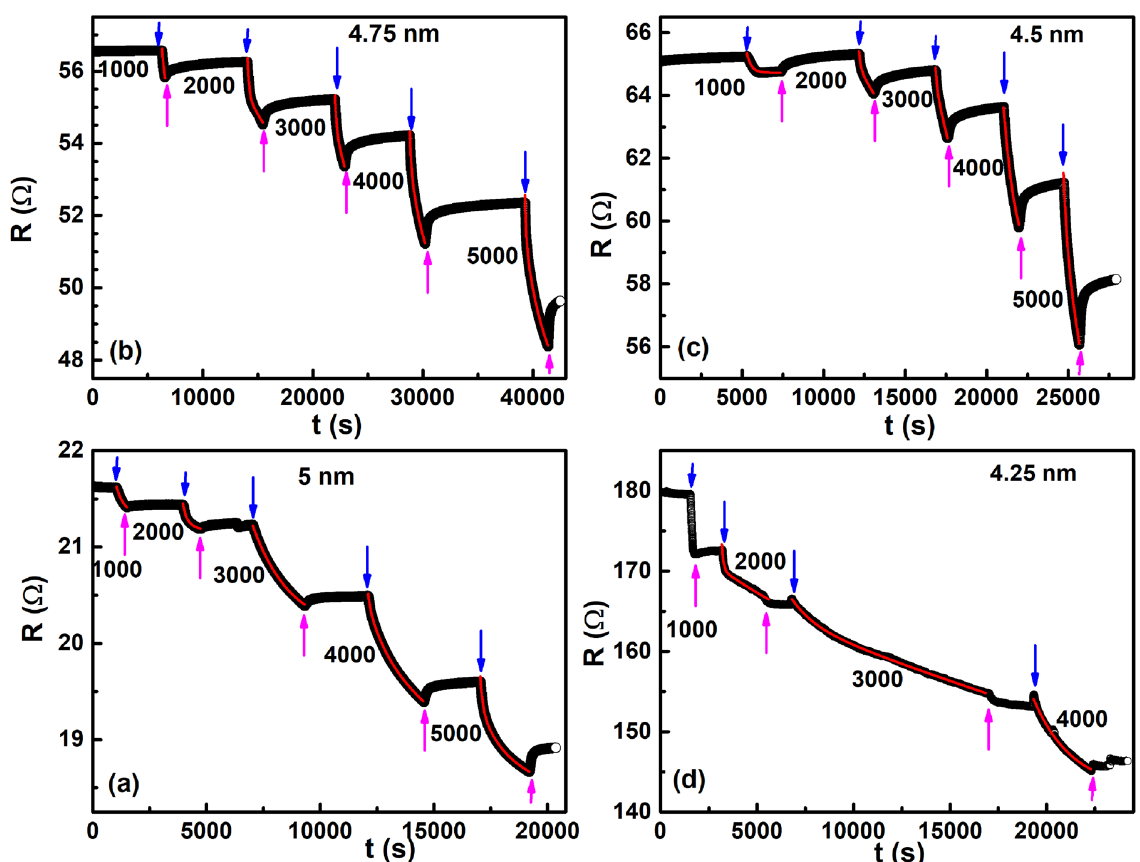
Figure 11. Change of resistance after subjecting low concentration hydrogen in ultra-thin films of Pd at 298 K with thickness varying as ( a ) 5 nm, ( b ) 4.75 nm, ( c ) 4.5 nm and ( d ) 4.25 nm. Blue colour arrow denotes the loading of hydrogen gas while the pink arrow shows the unloading of hydrogen gas at a given instance of time. Values of low concentration hydrogen gas varying from 1000 to 5000 ppm are also in thin films of Pd exposed to hydrogen 74 . However, the shift in the B.E.’s of the two smaller peaks was found to be higher at + 0.3 eV. Figure 11 shows the variation of resistance in ultra-thin films of Pd after they were subjected to low con- centrations of hydrogen (H 2 ) gas at room temperature (298 K) and atmospheric pressure (1 atm) conditions. From Fig. 11a–c, it is clear that the resistance of a given ultra-thin film decreases after being subjected to low concentration H 2 gas. Barr et al. showed that when ultra-thin island like films of Pd with inter-island separation near the percolation threshold are subjected to low concentration H 2 gas, charge transport happens via the tun- nelling mechanism 19 . There are two effects on the tunnelling mechanism on H 2 exposure: (i) for those hydrogen atoms that are adsorbed at the surface, the resistance increases due to an increase in the work function of the material and (ii) for the H atoms that are pushed inside from the surface into the Pd matrix, a lattice expansion of the fcc Pd lattice happens, the inter-island gap decreases resulting in a decrease of the initial resistance. Such a hydrogen absorption induced lattice expansion (HAILE) has been observed in meso wires of Pd 75 , nanofibers 76 , nanoclusters 77 as well as in ultra-thin films of Pd 27,36 . Hence, the immediate decrease of resistance in ultrathin films of Pd on loading of H 2 gas of varying concentrations, as shown in Fig. 11a–c is ascribed to the HAILE phenomenon. In contrast, in the thin film of 4.25 nm thickness (Fig. 11d), there is an initial increase in the resistance on hydrogen loading before the resistance starting to decrease. The time interval for the decrease of resistance is found to initially increase as the concentration of the hydrogen gas increases and then decrease afterwards. For instance, at 1000 ppm H 2 , the increase of resistance happened till ∼ 11 s after hydrogen exposure and then started to decrease; for 2000 ppm R increased till 17 s before starting to decrease while for 3000 ppm, it increased till 73 s before the decrease. However, on further increase of H 2 gas to 4000 ppm, R increased till only 54 s after hydrogen loading before eventually starting to decrease. Bulk Pd metal’s surface is very well known for its excellent catalytic response to an incoming H 2 gas molecule, wherein, they get broken to form two H atoms on the Pd’s surface according to the following reaction 36,78 :